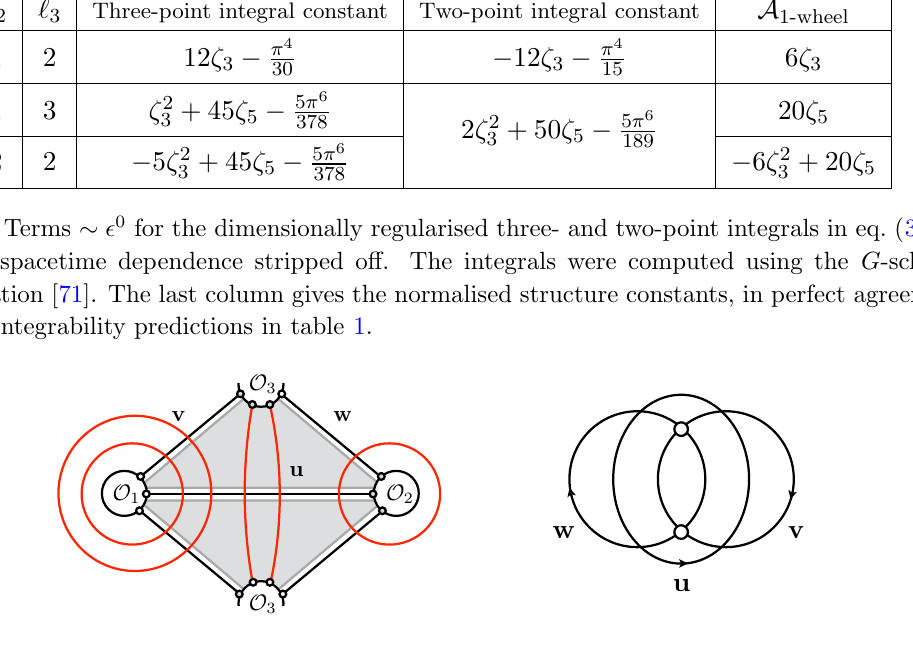
Figure 16 . On the left, a Feynman diagram contributing to the structure constant between a pair of BMN operators (left- and right-hand sides) and the protected puncture it down into two hexagons as shown here. The magnons circulate along the wheels surrounding operators 1 and 2, if not for m of them, which terminate on in the \bottom" channel (12) and by v and w those corresponding to the \adjacent" channels (13) and (23); by charge conservation, matrix part for the process. Each circle stands for a stack of lines with corresponding rapidities. Crossings represent R matrices and blobs their shifted